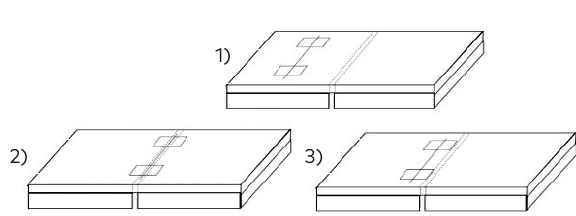
Figure 4. Axle load positions in respect of the joint